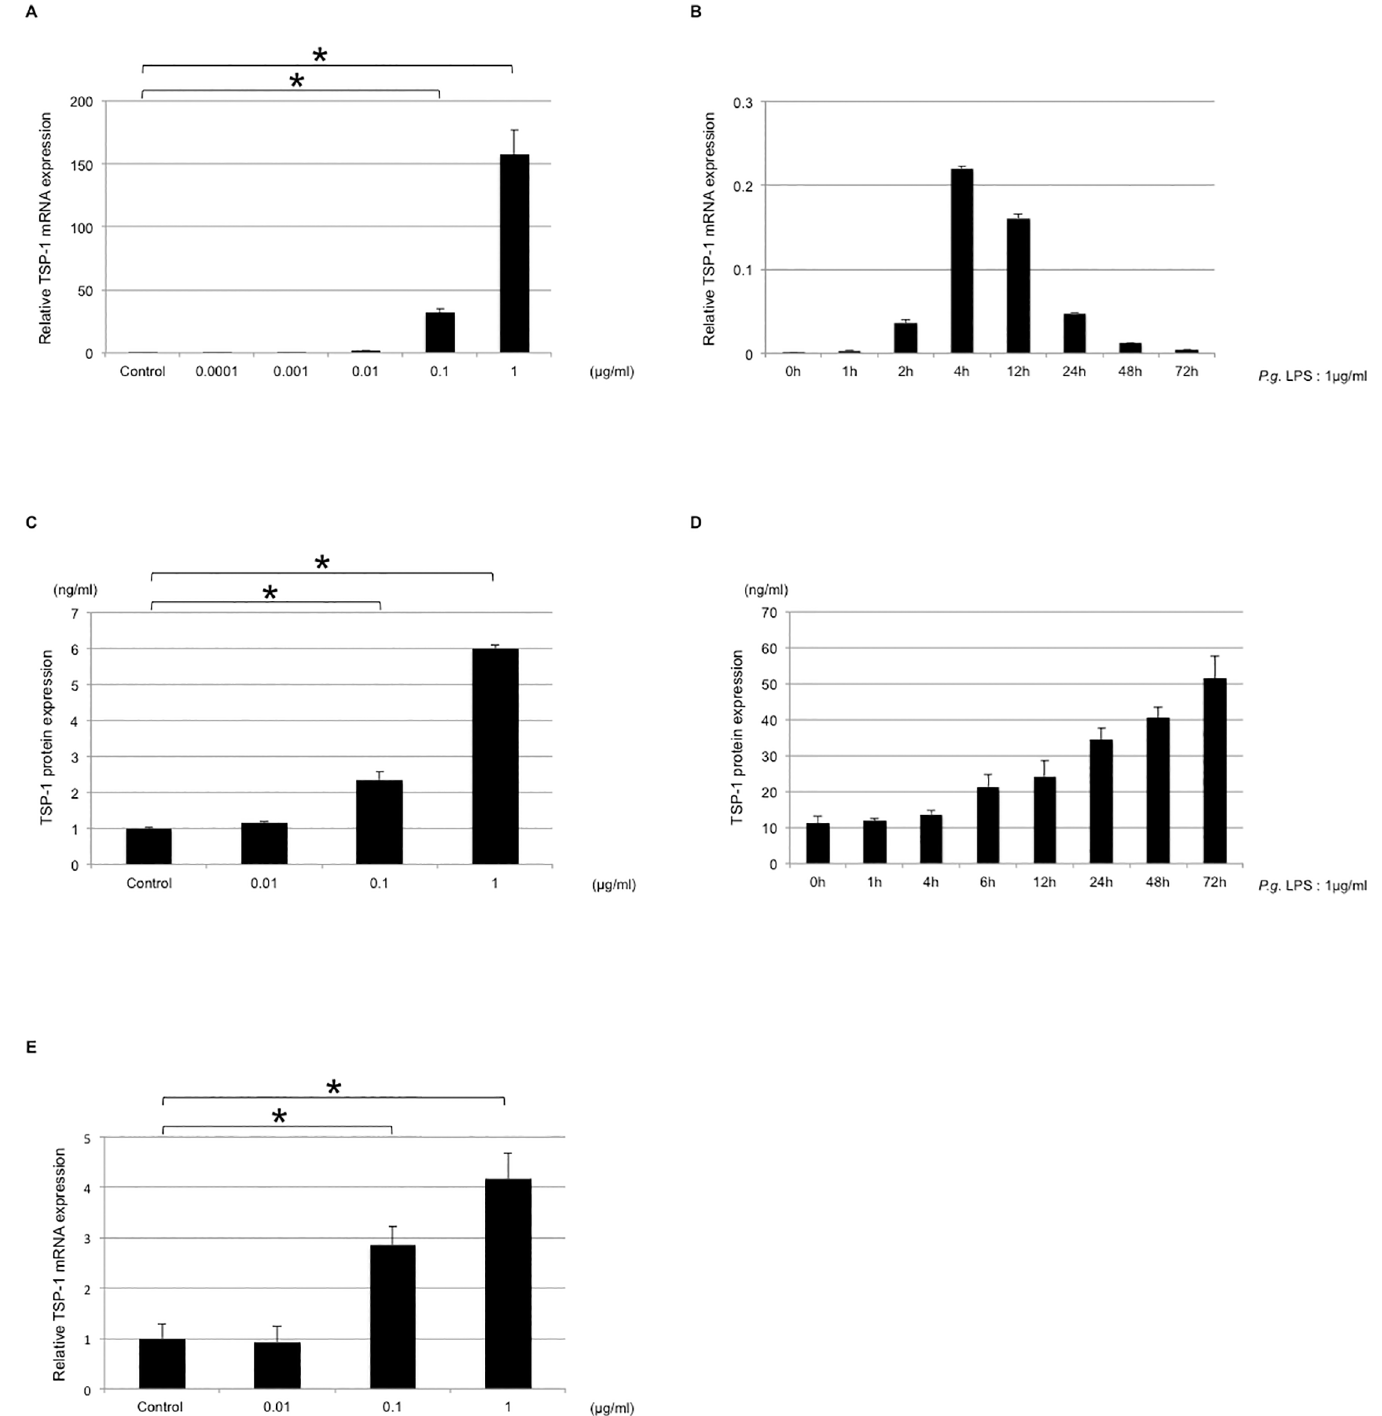
Fig 2. Upregulation of TSP-1 in THP-1 cells by P. gingivalis LPS stimulation. (A) THP-1 cells were stimulated by P. gingivalis LPS at concentrations of 0, 0.0001, 0.001, 0.01, 0.1, or 1.0 μ g/ml for 4 h. P. gingivalis LPS increased TSP-1 mRNA expression in a dose-dependent manner in THP-1 cells. (B) THP-1 cells were stimulated by 1.0 µ g/ml of P. gingivalis LPS for 0, 1, 2, 4, 12, 24, 48, or 72 h. P. gingivalis LPS increased TSP-1 mRNA expression in a time- dependent manner in THP-1 cells. (C) THP-1 cells were stimulated with P. gingivalis LPS at concentrations of 0, 0.01, 0.1, or 1.0 μ g/ml for 72 h. P. gingivalis LPS increased TSP-1 protein production in a dose-dependent manner in THP-1 cells. (D) THP-1 cells were stimulated with 1.0 μ g/ml of P. gingivalis LPS for 0, 1, 4, 6, 12, 24, 48, or 72 h. P. gingivalis LPS increased TSP-1 protein production in a time-dependent manner in THP-1 cells. (E) PMA-treated THP-1 cells